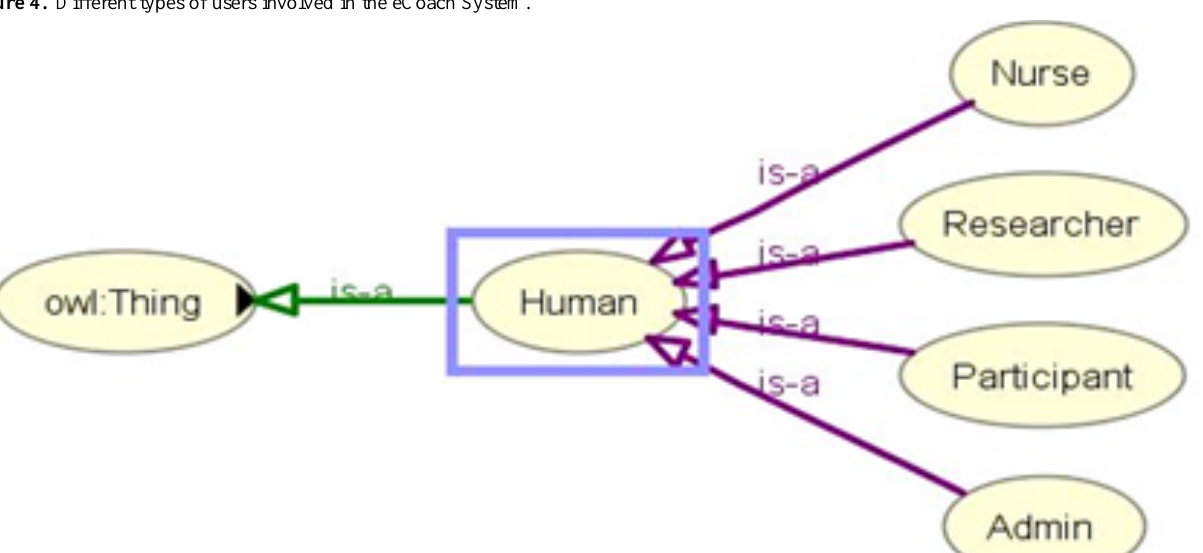
Figure 4. Different types of users involved in the eCoach